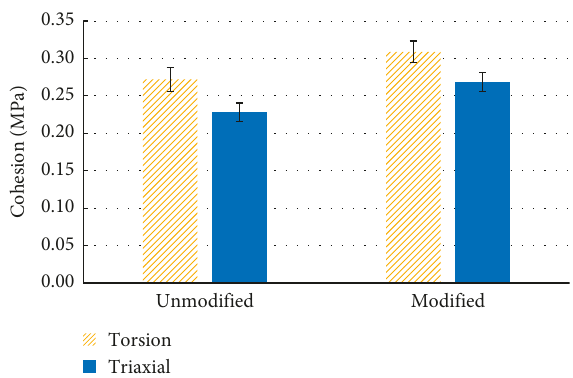
Figure 12: Results of cohesion C of different types of asphalt (60 ° C).